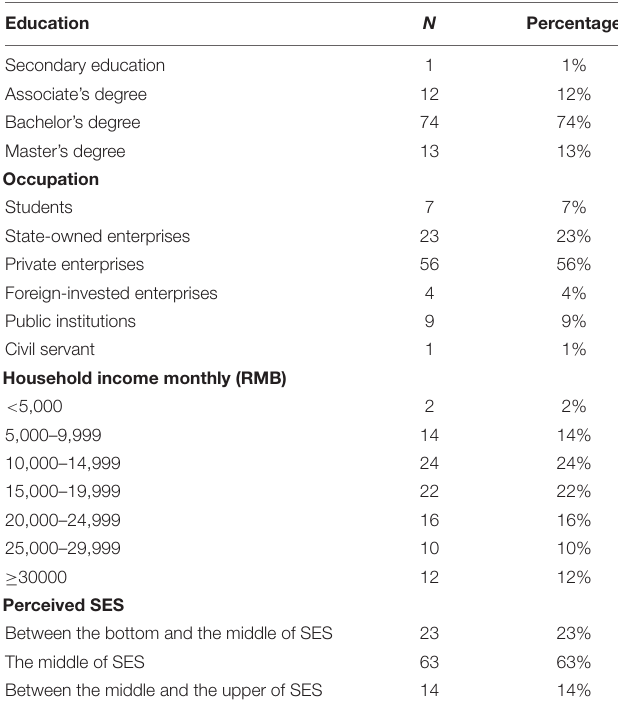
TABLE 1 | Description of participants’ demographics in Study